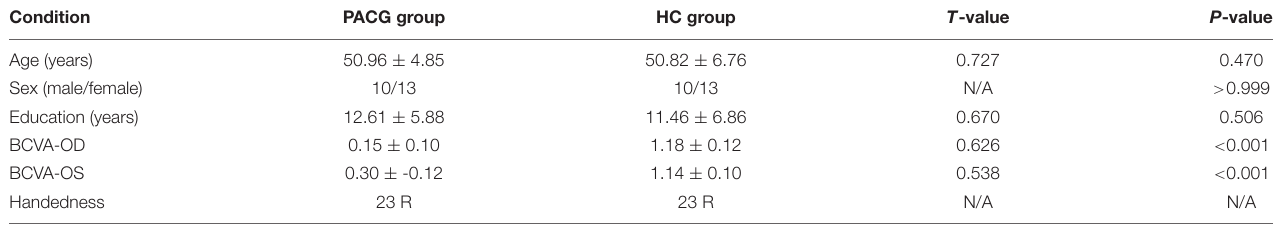
TABLE 1 | Demographic and clinical measurements between patients with primary angle-closure glaucoma (PACG) and healthy controls (HCs). Condition